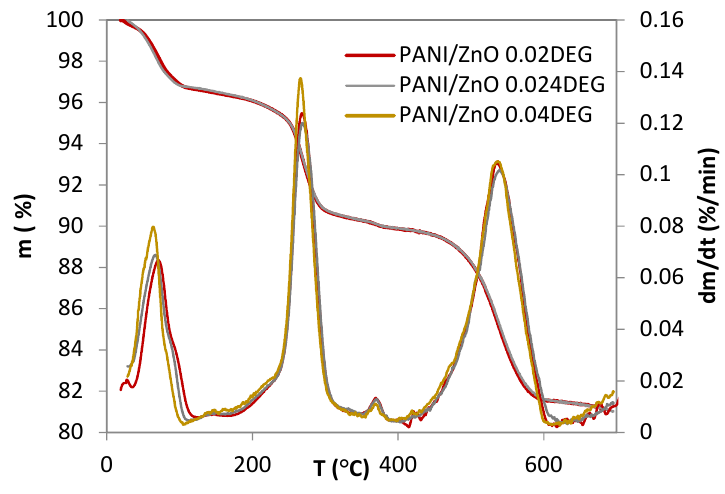
Figure 2. Thermogravimetric (TG) and derivative thermogravimetric (DTG) curves of PANI/ZnO composites.